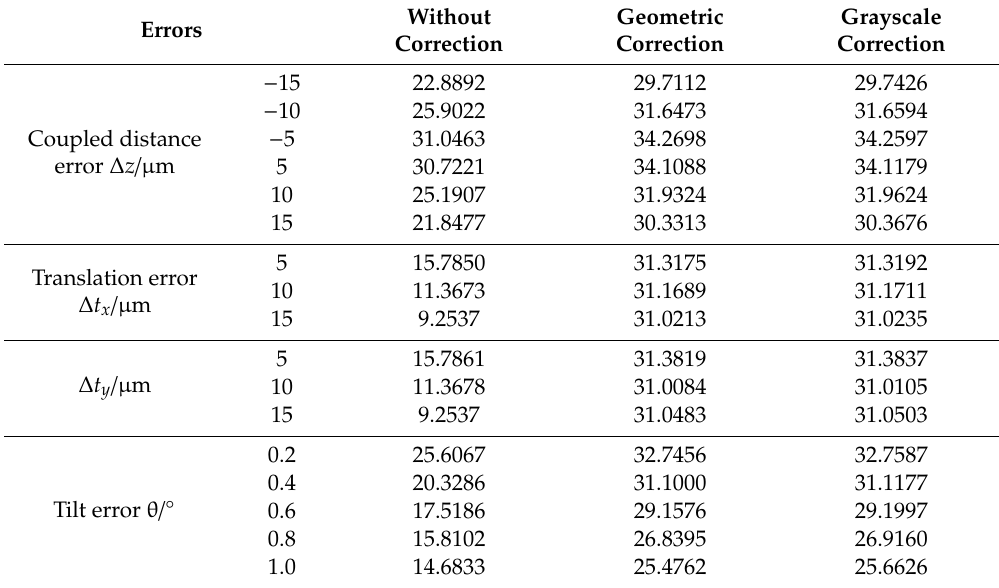
Table 3. Correction results for distorted light-field images with di ff erent orientation